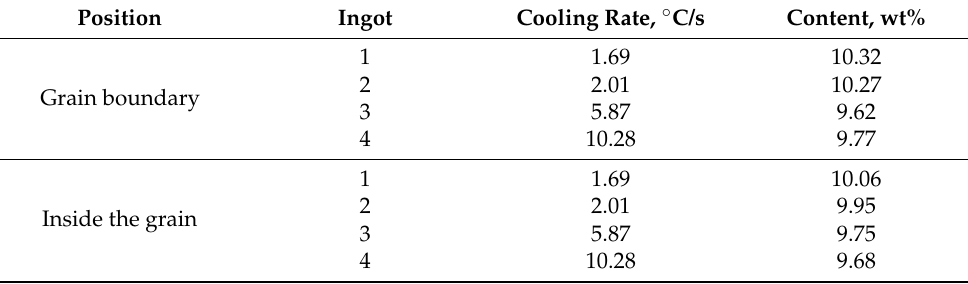
Table 5. Average Al content in the center of the ingot with different diameters.